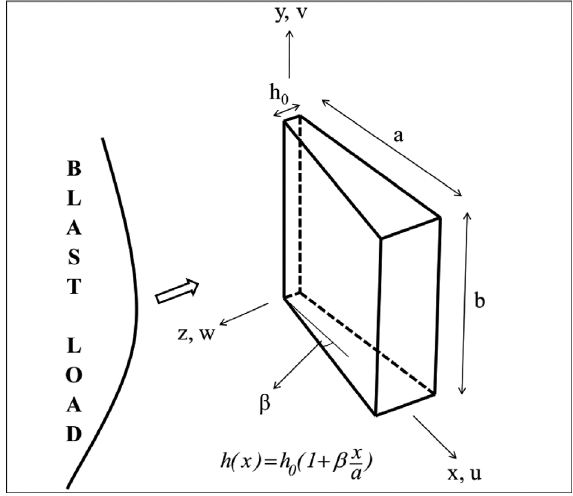
Fig. 1. The representation of the tapered plate subjected to blast